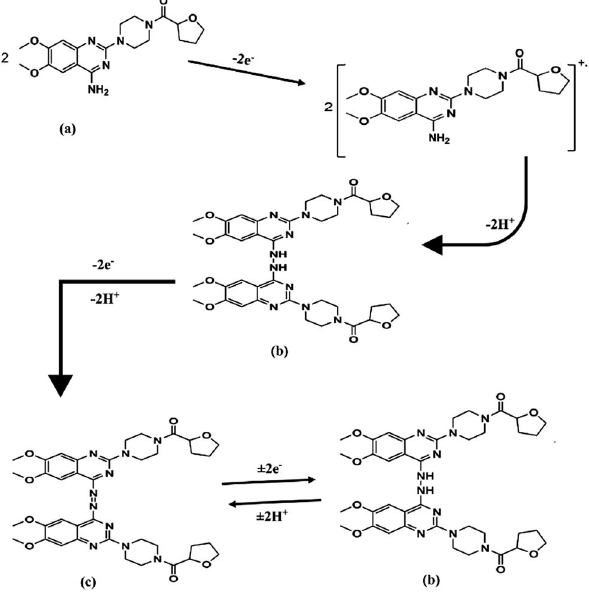
Scheme 1. Suggested mechanism for the electrochemical oxidation of terazosin.